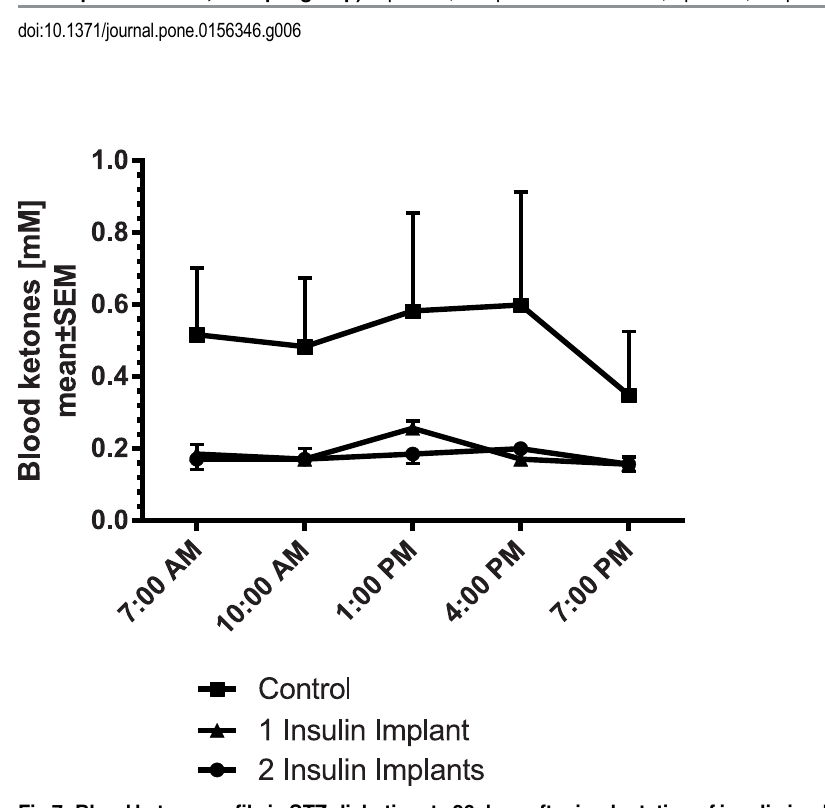
PLOS ONE | DOI:10.1371/journal.pone.0156346 June 2,